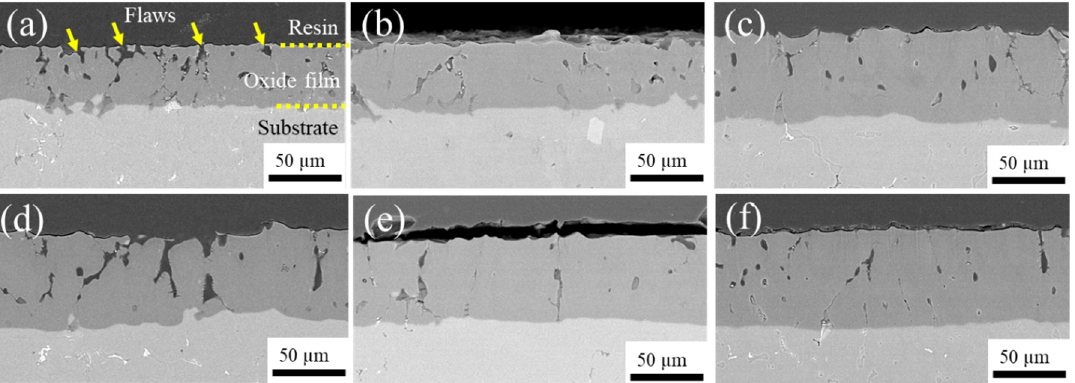
Figure 9. Cross-section micrographs of anodic oxide films on different anodized samples (white dashed lines show oxide film boundaries): ( a ) 2-A, ( b ) 2-N, ( c ) 2-S, ( d ) 4-A, ( e ) 4-N, and ( f ) 4-S.